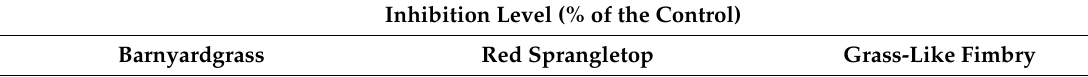
Table 2. Effect of OM 5930 rice crystallized by-product on the survival of pre-germinated barnyardgrass, red sprangletop, and grass-like fimbry seed.